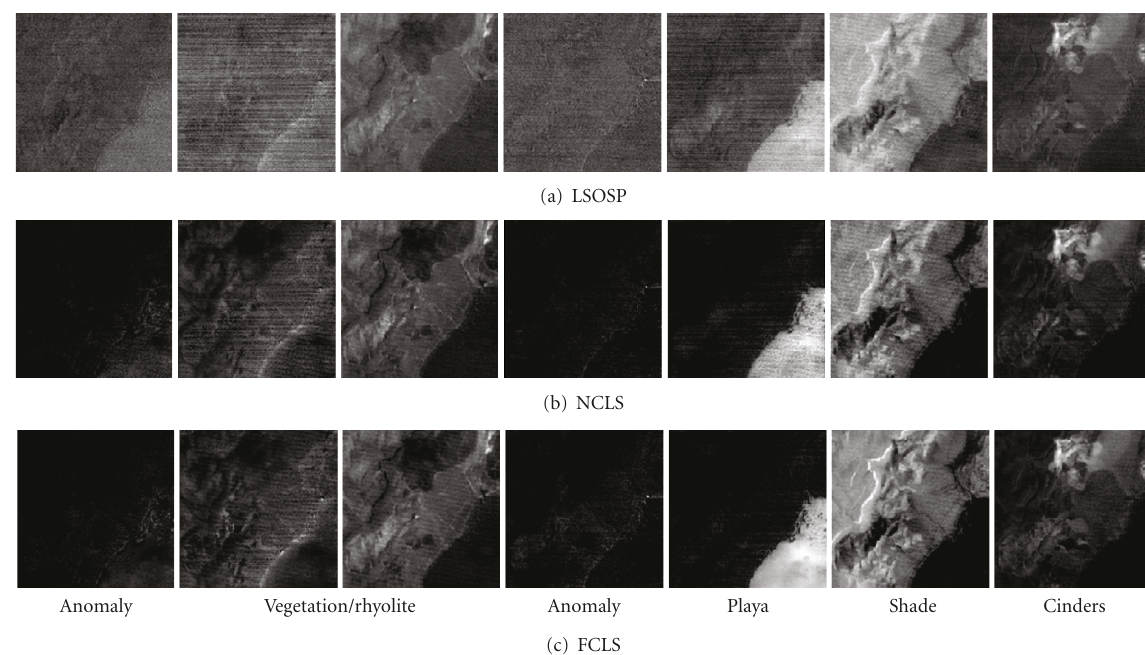
Figure 34: LSOSP, NCLS, and FCLS unmixed results using signatures of samples in Figure 33(d).